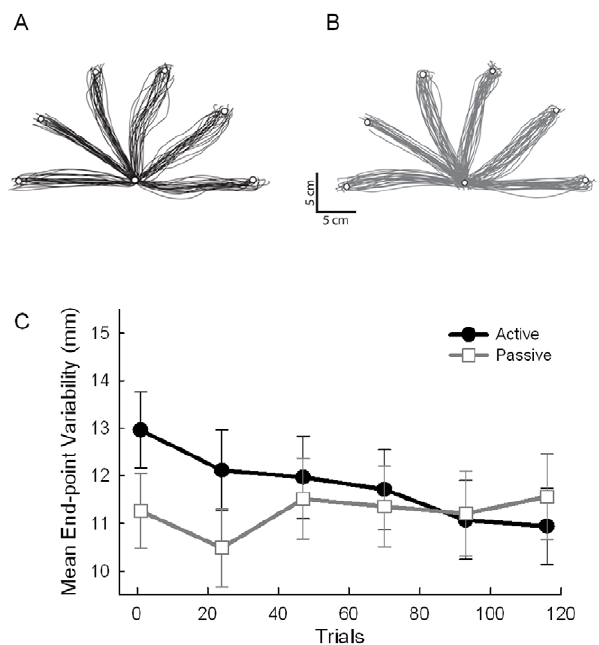
Figure 2. Motor learning results. Training trajectories from a representative participant in the active (participant JD) and passive training groups (participant LP) are shown in Panels A and B, respectively. Panel C shows mean end-point variability of the training movements for the active and passive training groups over trial bins of 23 trials. Error bars represent 95% confidence intervals.